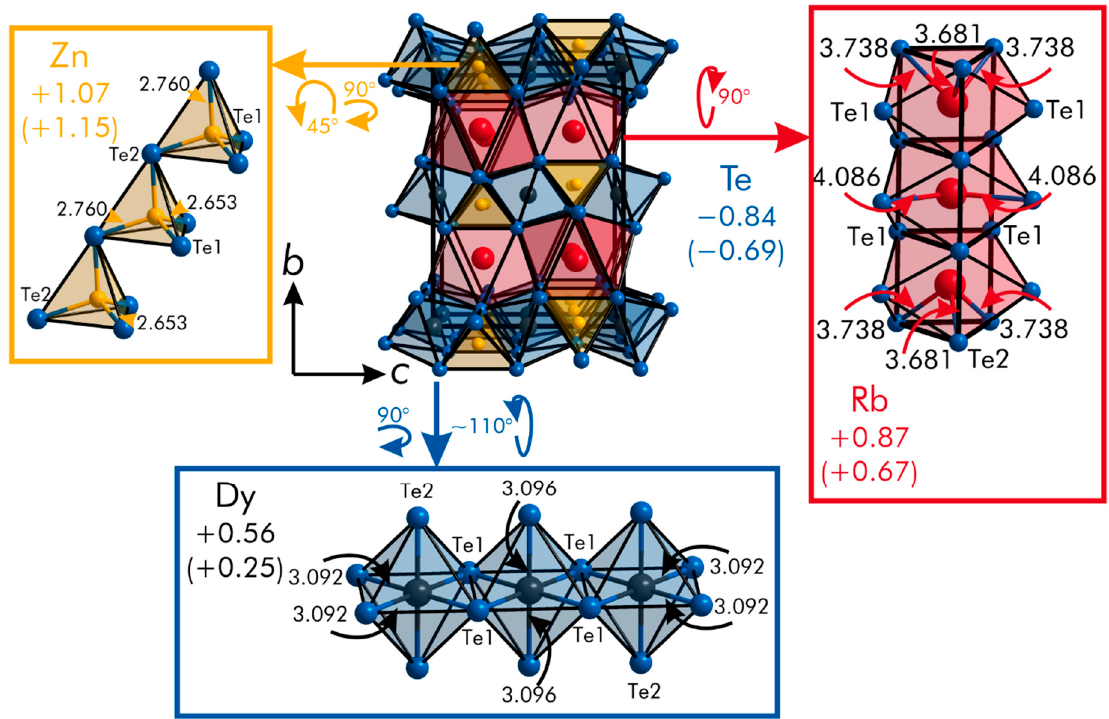
Figure 2. Representation of the crystal structure of the ALnZnTe 3 -type tellurides: the different types of tellurium polyhedra enclosing the alkaline metals, lanthanides, and zinc atoms, respectively, are shown in the insets, while the Mulliken and Löwdin (in parentheses) charges computed for RbDyZnTe 3 have been included. The Mulliken and Löwdin charges of tellurium correspond to the averaged charges of both crystallographically independent tellurium sites, for which the charges solely differ by 0.05 e.